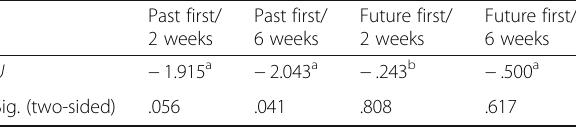
Table 7 Wilcoxon test for before and after preference scores per